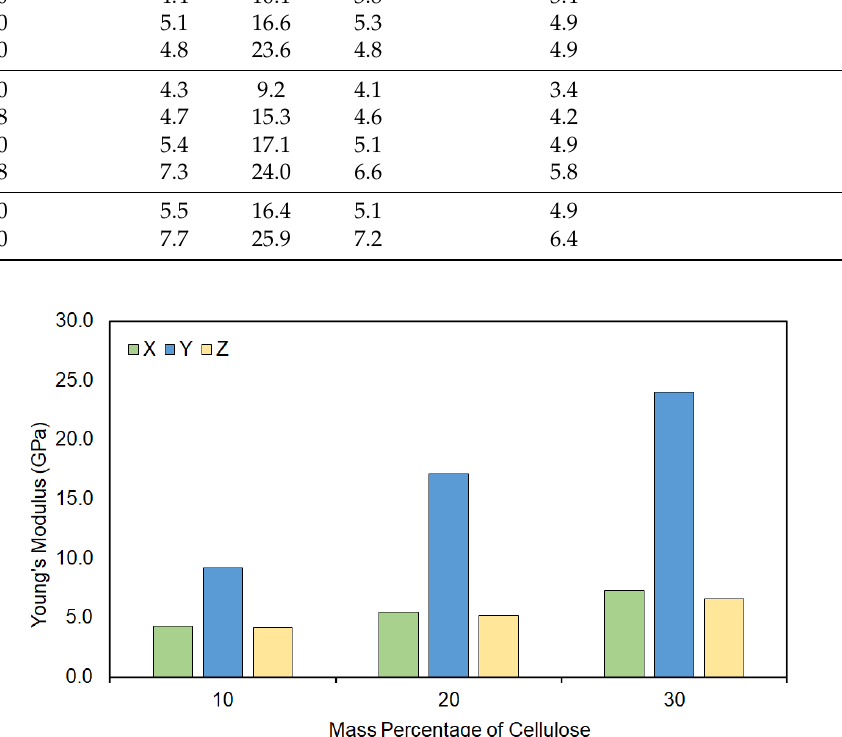
Figure 8. Young’s modulus of a 10 chain cellulose fiber surrounded by 50 monomer long PP chains. Three different models are reported, each with a different mass percentage of cellulose compared to the total mass of the unit cell.